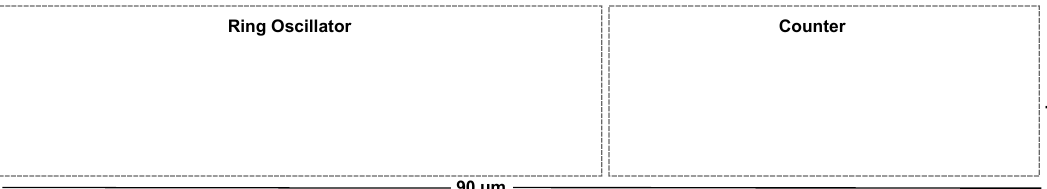
Figure 7. Layout of the proposed temperature sensor.